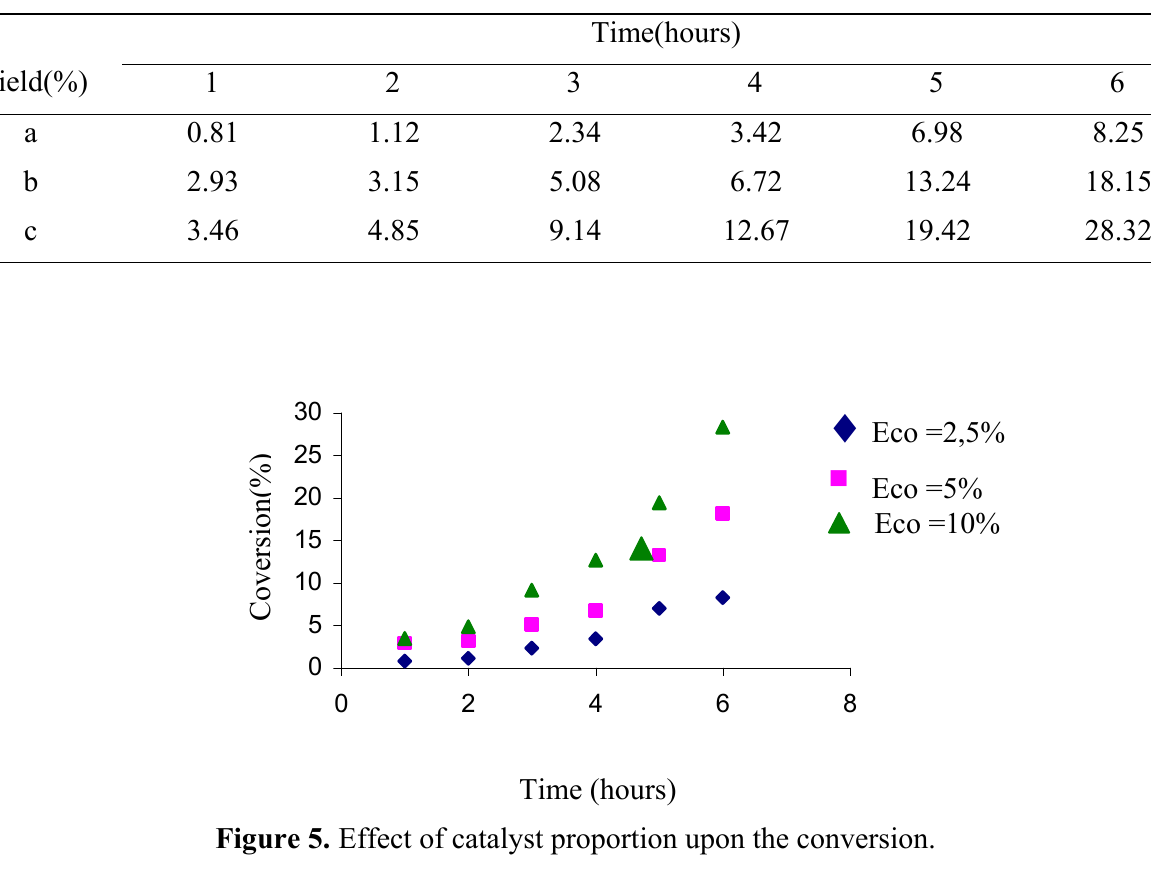
Table 4. Conversions with time for 10.75 mol/l of THF, 5.67 mol/l of phthalic anhydride, 0.19 mol/l of acetic anhydride and the amounts of H-Maghnite 0.25M were: a) 2.5% , b)5% , c)10%